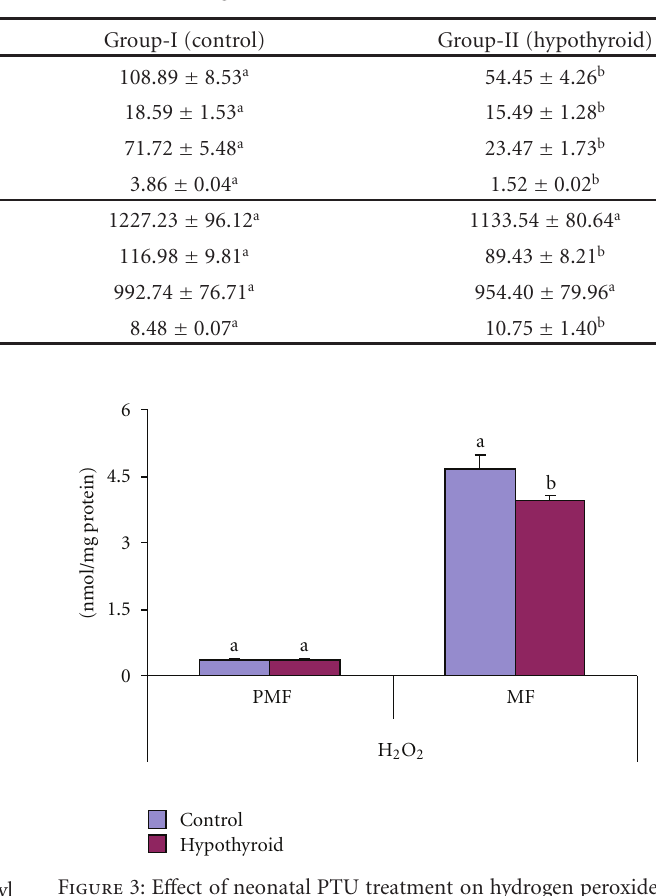
Table 5: E ff ect of neonatal PTU treatment on total, oxidized, reduced glutathione contents (nmol thiols/g tissue) of testes of rats. Data are expressed as mean ± S.D. of 5 observations and subjected to unpaired Student’s t -test. Statistical significance was accepted at P < 0 . 05. Control and hypothyroid groups were found to di ff er significantly at P < 0 . 05 as represented by superscripts of di ff erent letters. Group-I (Control): 30 day old control rats; Group-II (Hypothyroid): 30-day-old rats with PTU treatment from day 1 postpartum to day 30 postpartum; T-GSH-eq: total GSH equivalent; GSH: reduced glutathione, GSSG: oxidized glutathione.